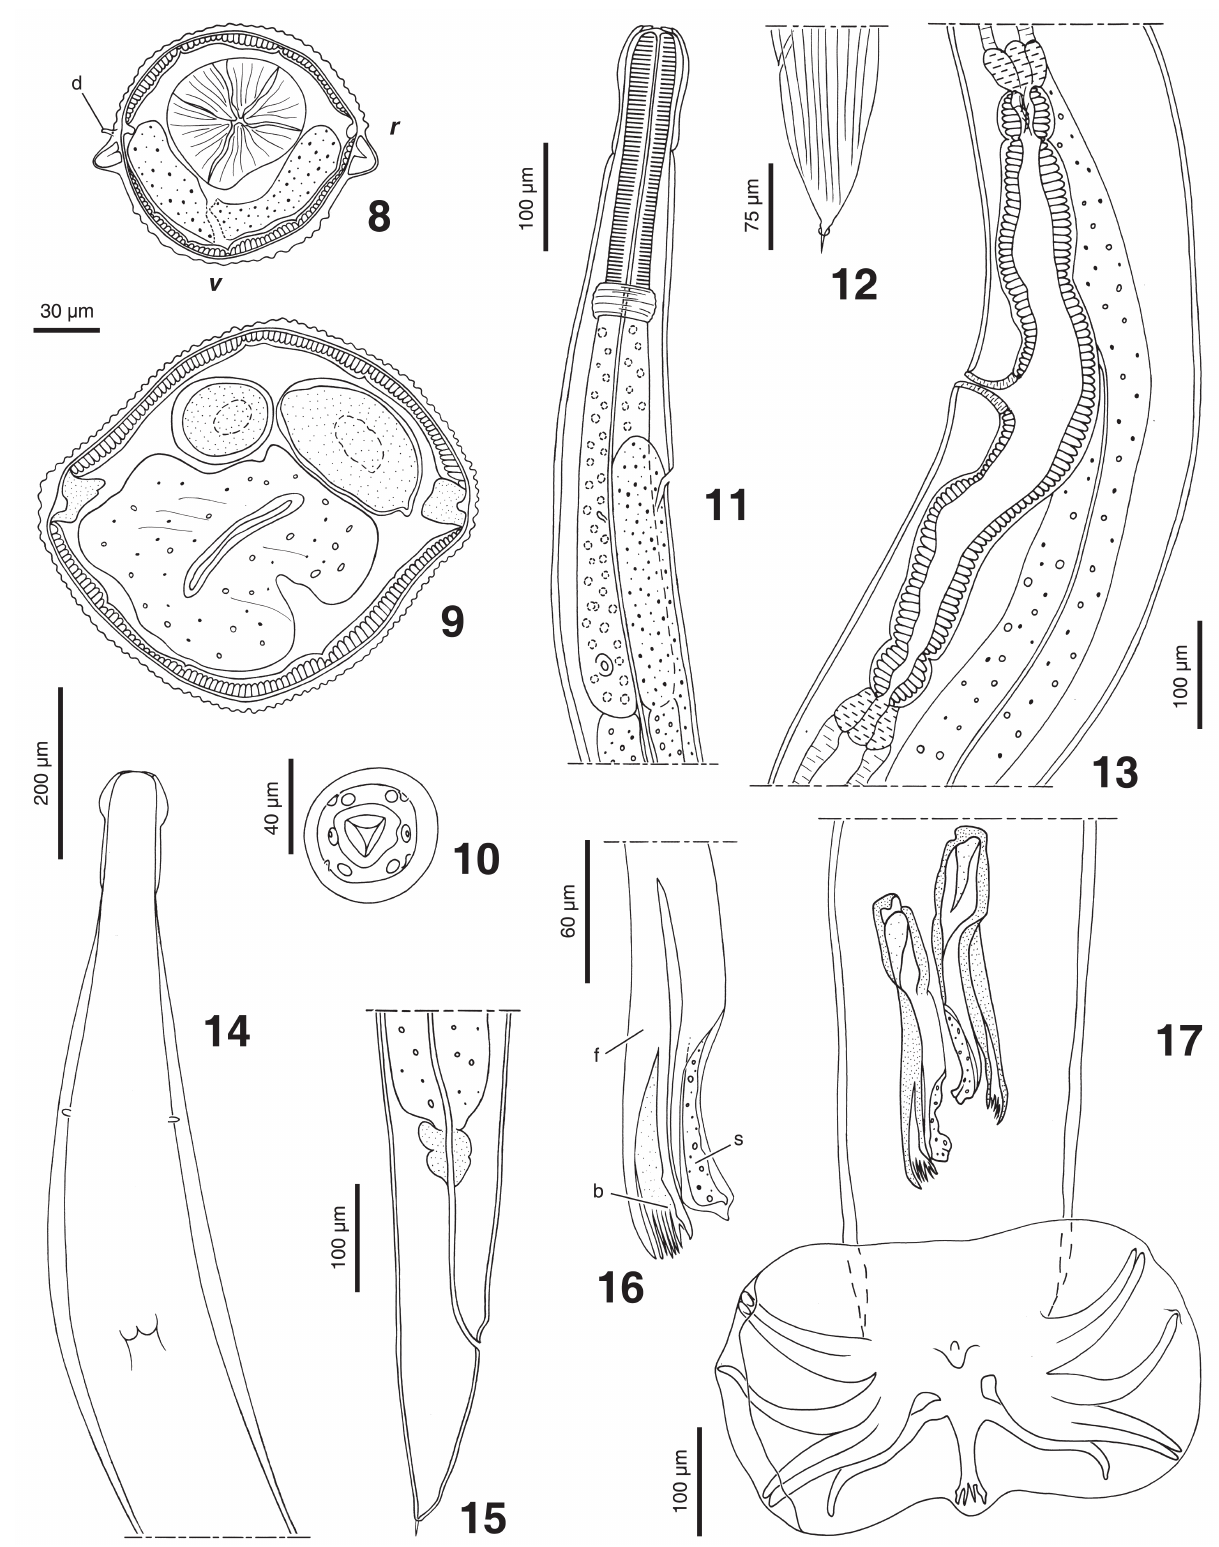
8-17. – Oswaldocruzia burseyi n. sp. 8, 9. Transverse sections of body, female paratype, 9.4 mm long. 8 - at level of left deirid. 9 - at mid-body (5 mm from apex). 10-15. Female. 10 - head, apical view. 11 - anterior extremity, right lateral view. 12 - tail, with disap- pearance of cuticular ridges, left lateral view. 13 - ovejector, left lateral view. 14 - silhouette with cervical alae, dorsal view. 15 - posterior extremity, right lateral view. 16, 17. Male. 16 - lamina of dissected right spicule, ventral view. 17 - caudal bursa, ventral view. Abbreviations: v, ventral side; r, right side; d, deirid; f, fork; s, shoe; b, blade. Sections are orientated as Parasite, 2006, 13 , Mémoire